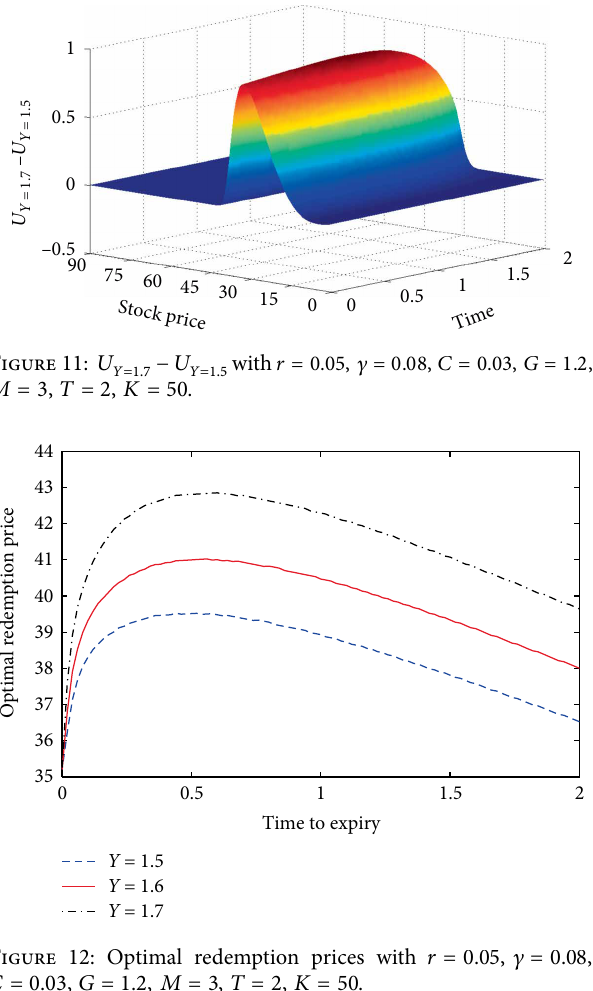
9: with 𝑟 = 0.05, 𝛾 = 0.08, 𝐶 = 0.03, 𝑈 𝑀=1 − 𝑈 𝑀=3 . 𝐺 = 1.2,𝑌 = 1.5, 𝑇 = 2, 𝐾 = 50